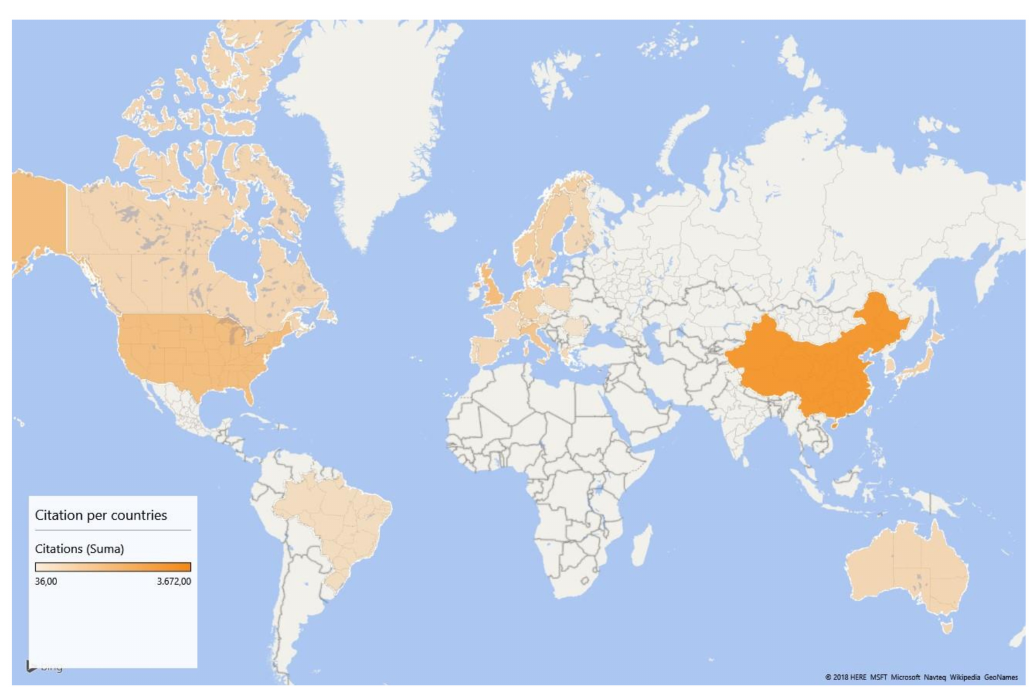
Figure 2. Articles per country.